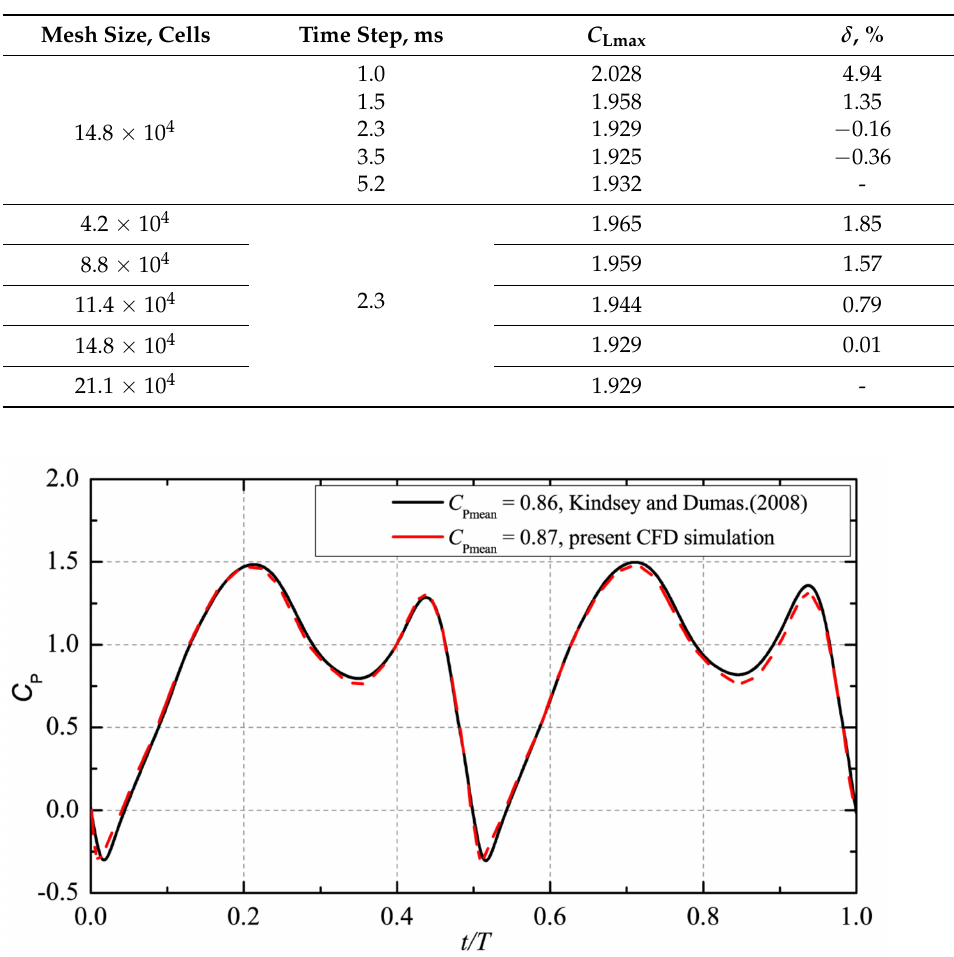
Figure 5. Time evolution of total power coefficient C P at Re = 1100 [27].